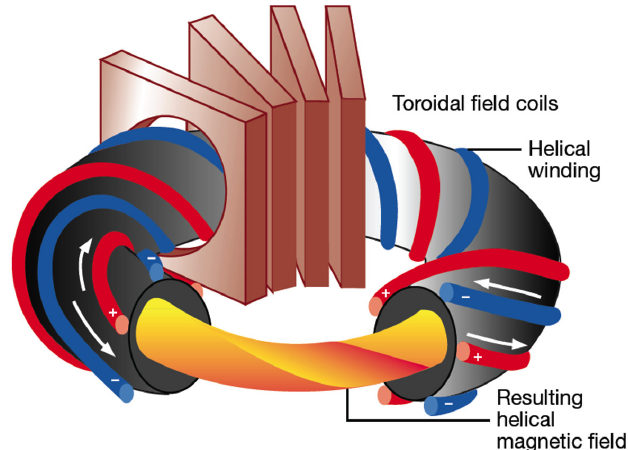
Fig. 8. – In a stellarator, helical coils external to the plasma ring create a supplementary magnetic field that, in combination with the main toroidal magnetic field, confines the plasma.